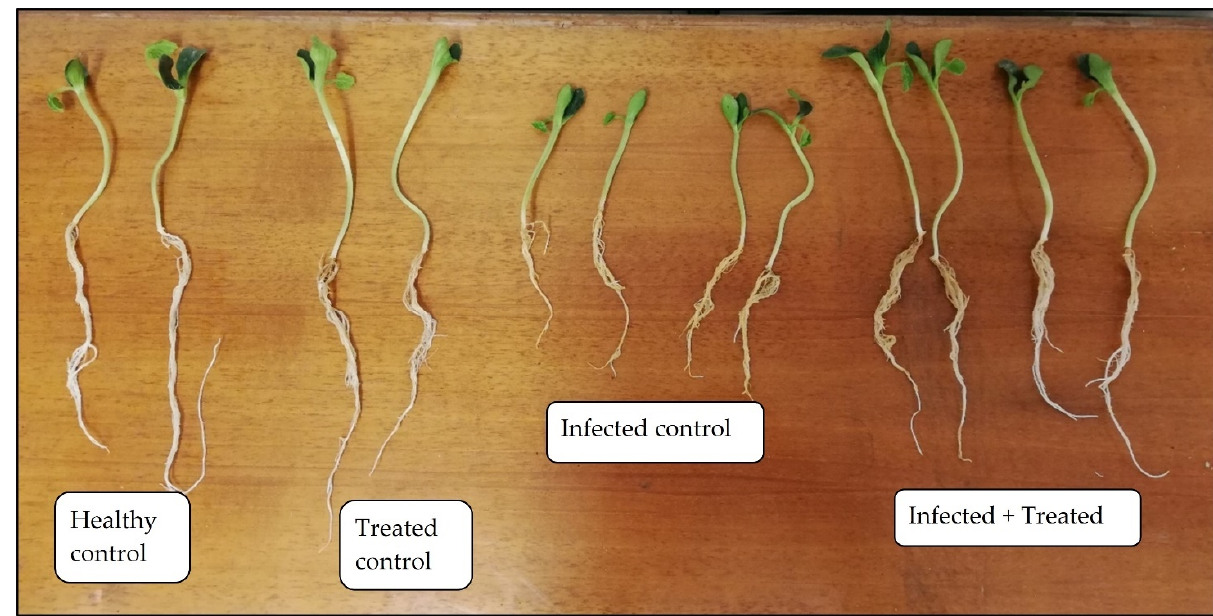
Figure 8. Effects of the treatment with the undiluted giant reed extract on the Pythium ultimum 22–zucchini pathosystem in sand. Plantlet development in the infected and treated trays (on the right) compared to the different controls (i.e., healthy, treated, or infected) 16 days after the treatment.